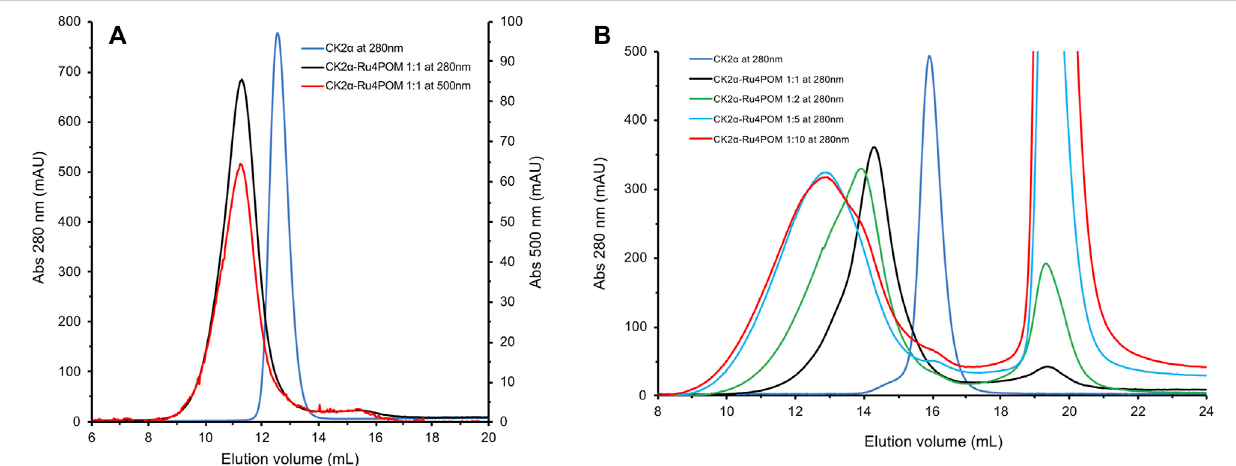
FIGURE 5 | SEC elution pro fi les of Ru 4 POM/CK2 α mixtures at different molar rations. (A) In black, the elution pro fi le recorded at 280 nm of a 1:1 mixture of Ru 4 POM:CK2 α ,in 25 mM Tris, 500 mM NaCl, 1 mM DTT, pH = 8.5, on a10/30 Superdex75 GLcolumn.On the basisof thecalibrationcurve ofthecolumn and on the comparison with monomeric CK2 α (blue curve) the black curve corresponds to the dimeric form of the enzyme. The perfect superposition of the peaks recorded at 280 and 500 nm (red curve) indicates the co-elution of CK2 α and Ru 4 POM and hence the formation of a stable complex. The absence of peaks corresponding to the single species suggests that the complex eluting at 11.3 ml has a stoichiometry (CK2 α ) 2 (Ru 4 POM) 2 . (B) Experiments were performed on a 10/30 Superdex 200 GL column,in25 mMTris,500 mMNaCl,1 mMDTT,pH=8.5,followedat280 nm.Inblueandblack,elutionpro fi lesoffreemonomericCK2 α andRu 4 POM:CK2 α in1:1 M ratio, respectively. Increasing amounts of Ru 4 POM induce the formation of larger oligomers, as evident by the lower elution volume of the peaks corresponding to molar rations2:1(showningreen)and5:1(shownincyan).Thewideningofthepeaksindicatestheco-existenceofdifferentoligomericspecies.Thefurtherincreaseto10:1(in red) does not vary the nature of the oligomeric forms, indicating that the saturation of the oligomerization process is reached at around 5:1 M